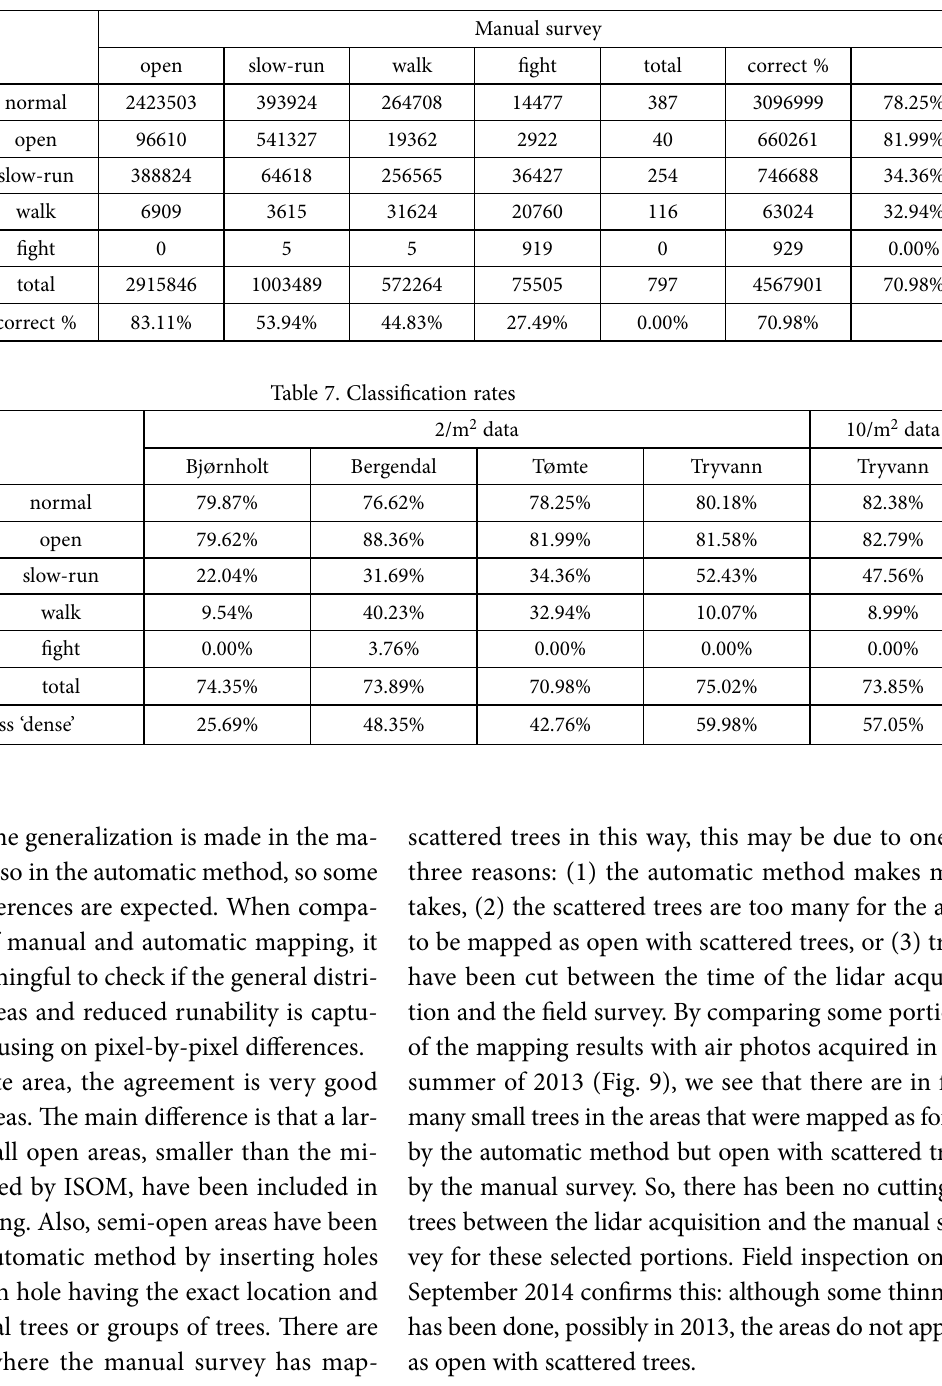
Table 6. Confusion matrix and classification rates for the Tømte